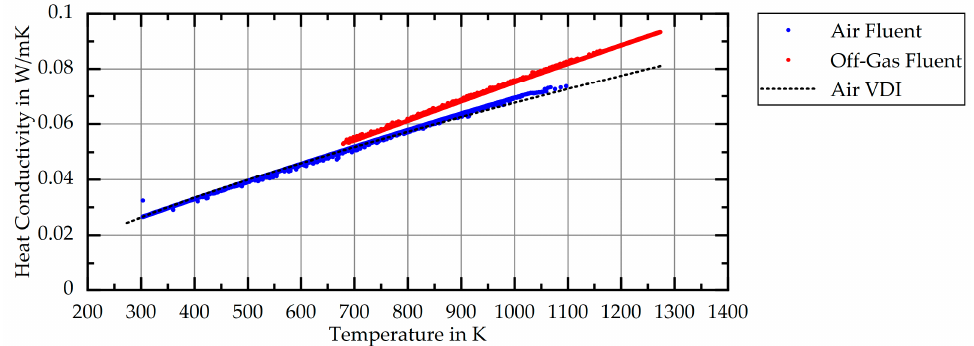
Figure A3. Sampled data points of the heat conductivity of air and off-gas at λ = 1.15 calculated in ANSYS ® Fluent in comparison with values from [21].